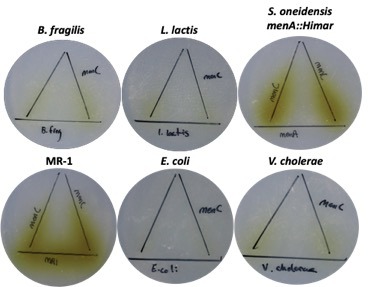
Various bacterial strains that can recover reduction of AQDS by S. oneidensis menC::Tn10.Each of the different bacterial strains was inoculated on the horizontal line and menC::Tn10 was inoculated on the vertical lines (x2). Reduction of AQDS (colorless) to AHQDS (yellow) is only observed by menC::Tn10 where it was growing in close proximity to any of the other bacterial strains. This suggests ACNQ is being produced by each of the bacterial strains except menC::Tn10.